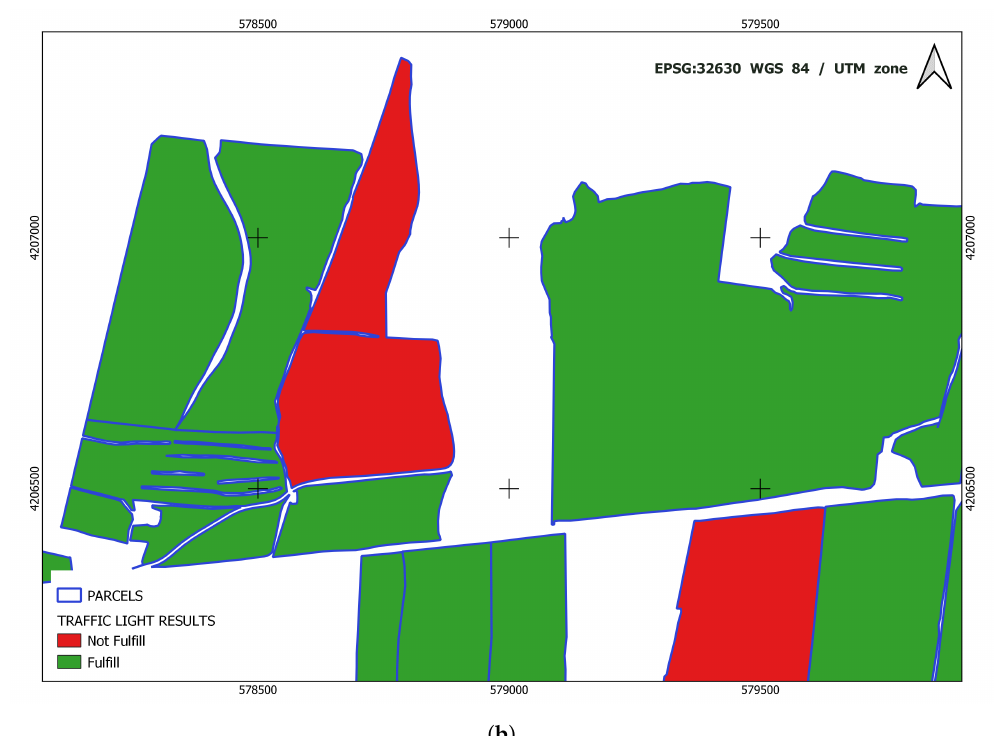
Figure 6. From pixel-level to object-level classification. ( a ) BirdsML prediction. ( b ) Results as traffic light